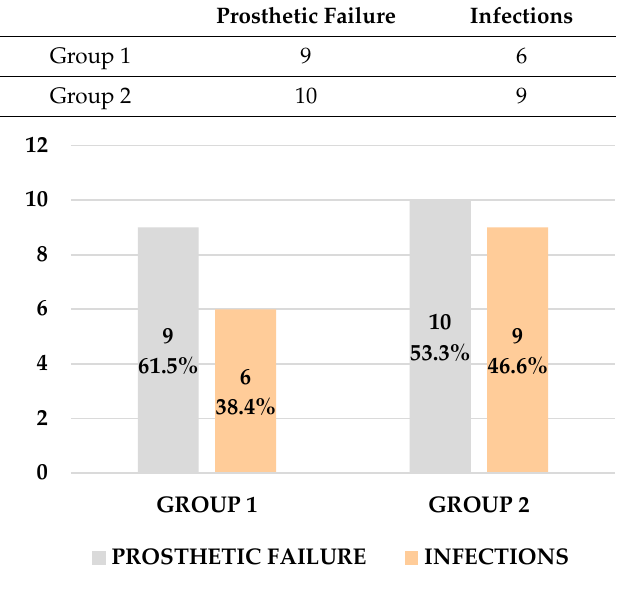
Table 5. Statistical analysis ( p > 0.005 denotes no statistical significance). BV Bone